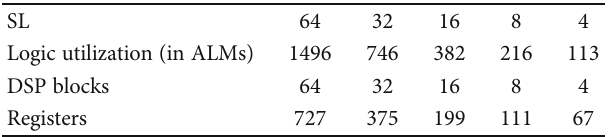
Figure 9: E ff ect of changing the segment length parameter on the hardware resources and the execution time. Table 2: FPGA HW resources.